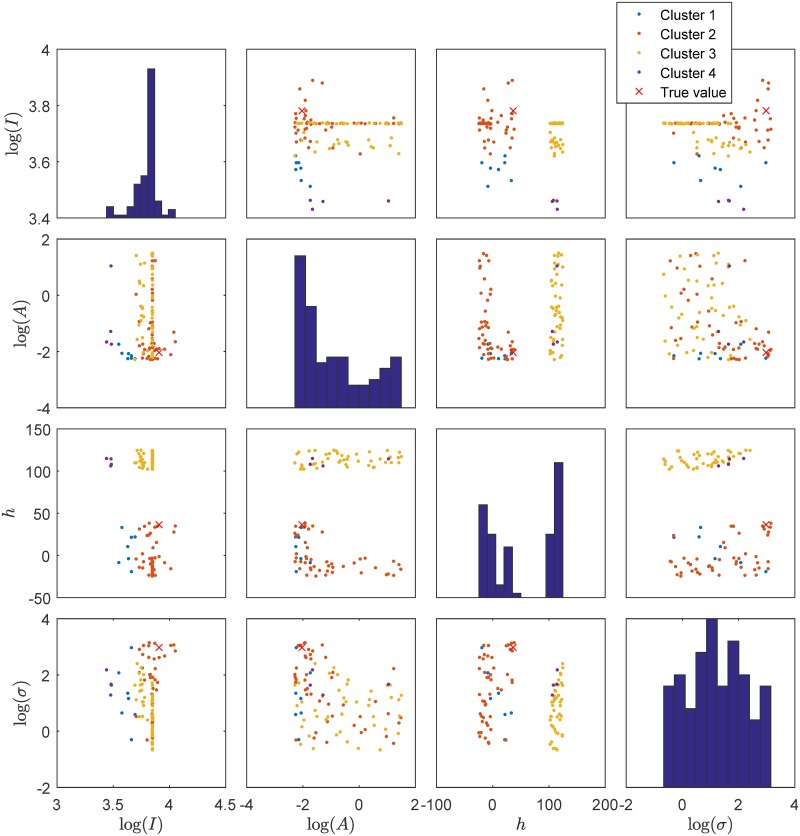
Scatter plot matrix of the clustering that occurs for the 100 nearest neighbors for the summary statistics for Tobs = 1000 of parameter log(I) = 3.9081, log(A) = −2.0343, h = 36.4150 and log(σ) = 2.9762.The red cross shows the true value of this parameter.